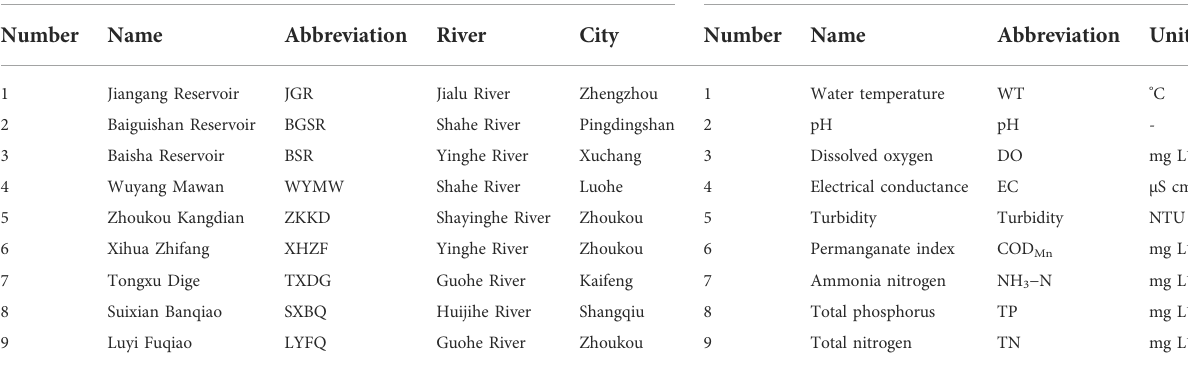
TABLE 1 Basic information of the monitoring sections and water quality indicators. Monitoring